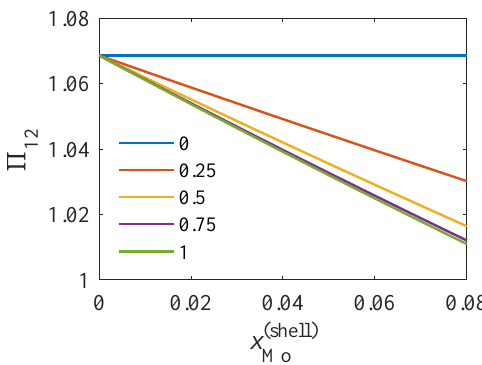
( shell ) (we used Mo